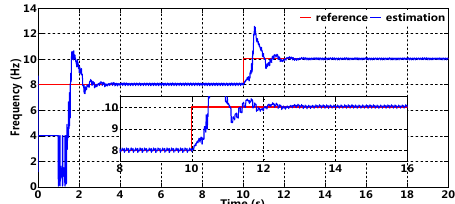
Figure 18. Fundamental frequency